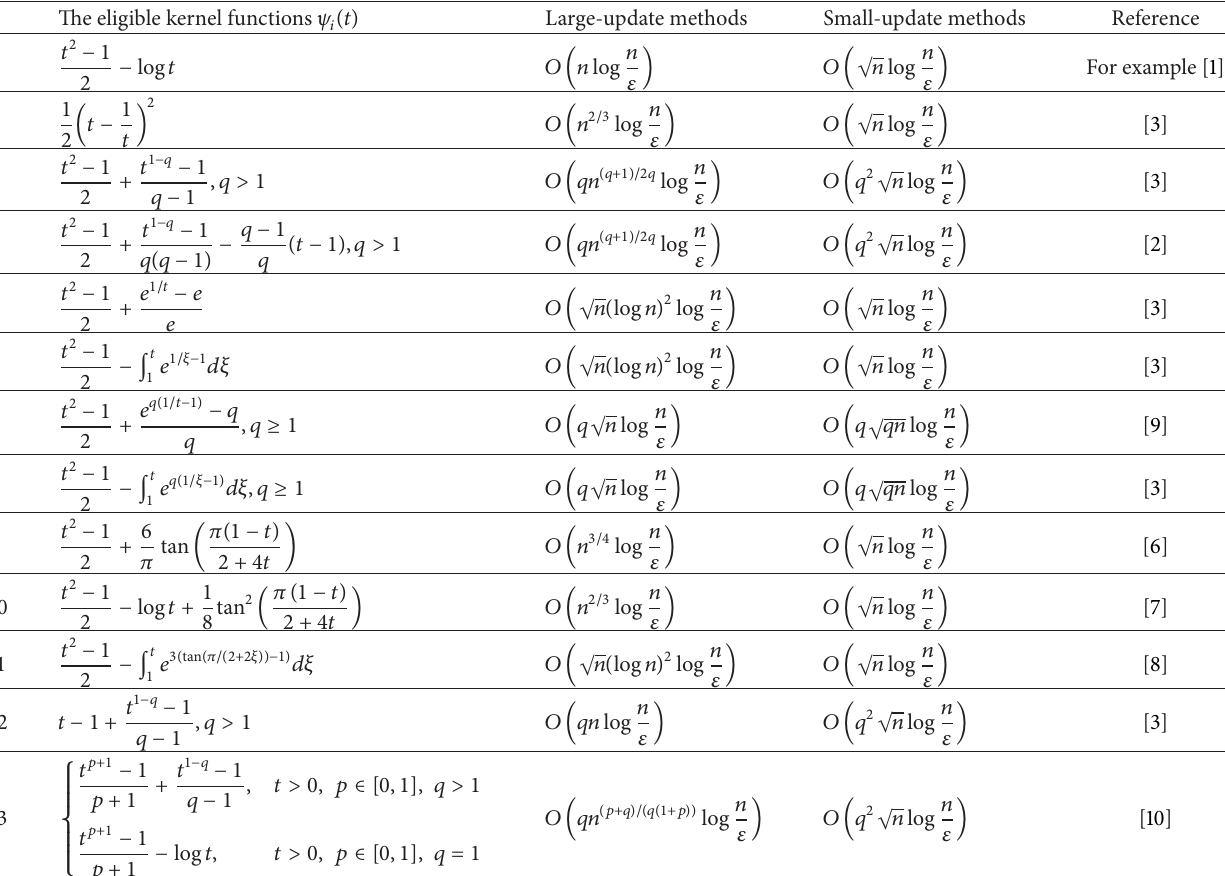
Table 1: Complexity results for the eligible kernel